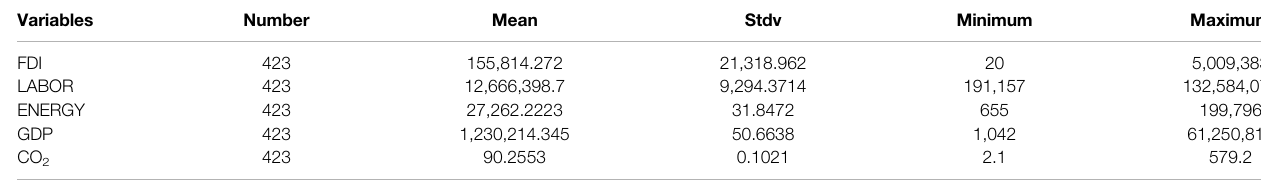
TABLE 3 | Descriptive statistics of input and output variables.